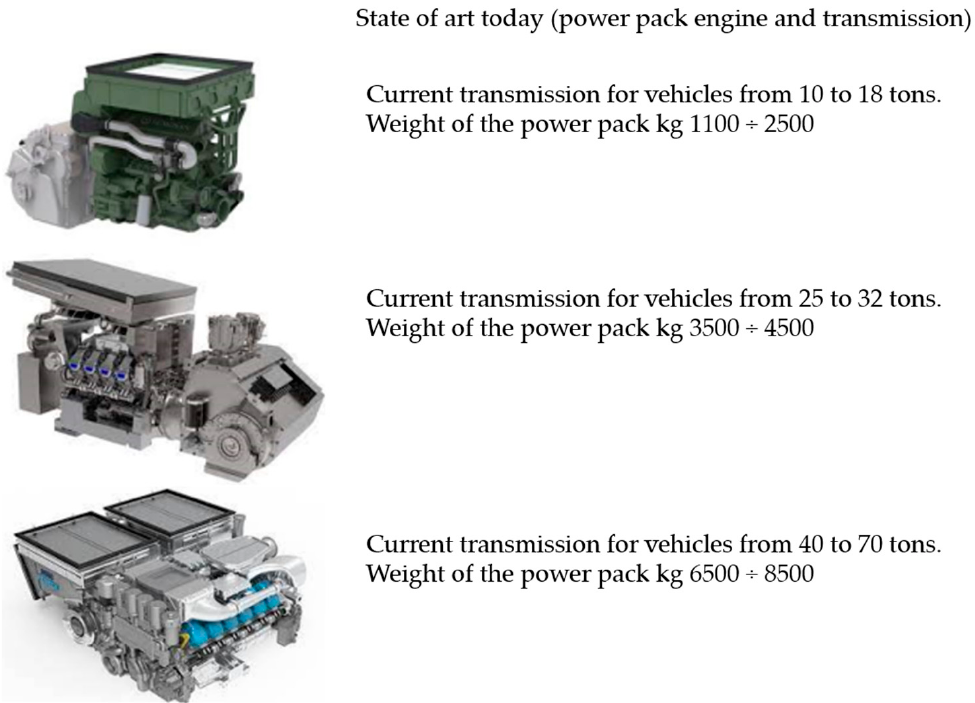
Figure 1. Available power packs for armored vehicles. The 10 to 18 tons vehicles use power packs from 1100 to 2500 kg. The 25 to 30 tons vehicles need 3.5 to 4.5 tons for the power pack. While for heavier vehicles, 6.5 to 8.5 tons are required. Table 1. Performance of an Automotive Traction Motor.